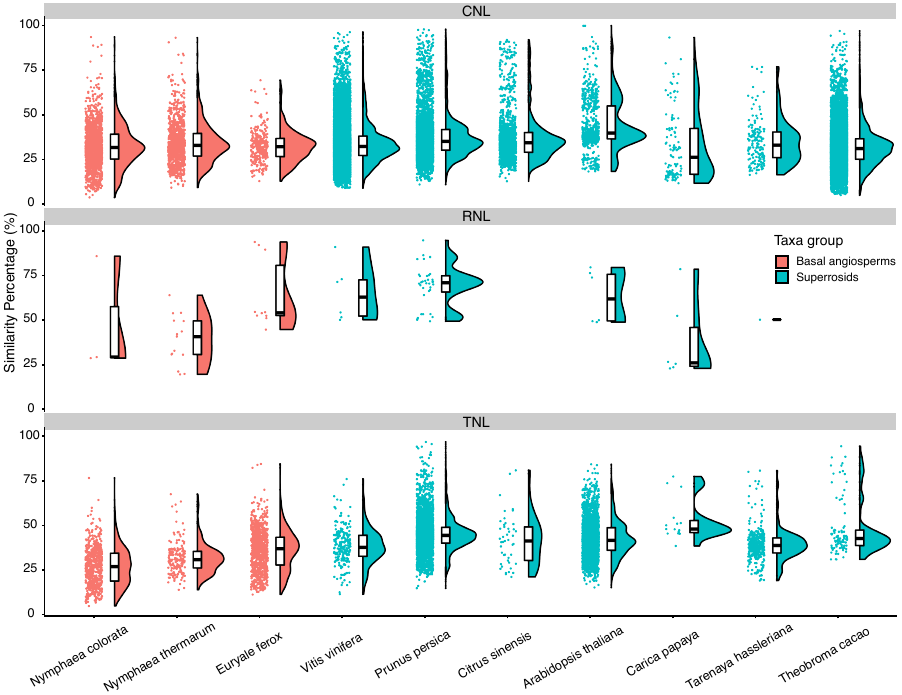
Figure 2. Similarity comparison of NLRs (CNL, RNL, TNL) in papaya and selected